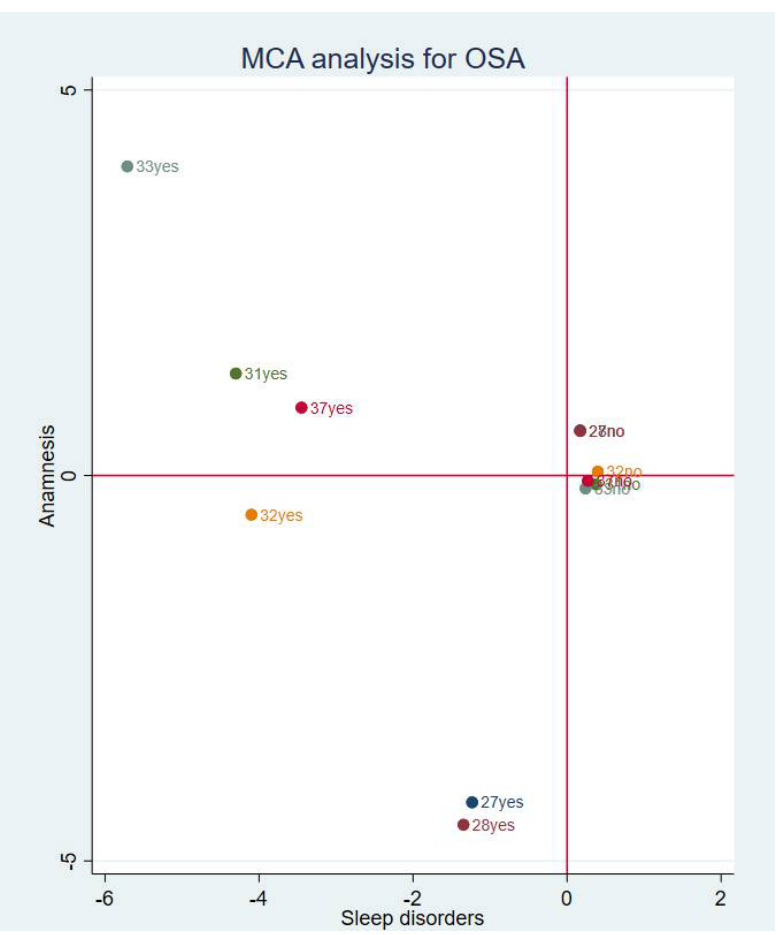
Figure 1. Two-dimensional map of MCA showing the projection of Items 27–28–31–32–33–37 on two dimensions (“sleep disorders” and “anamnesis”).